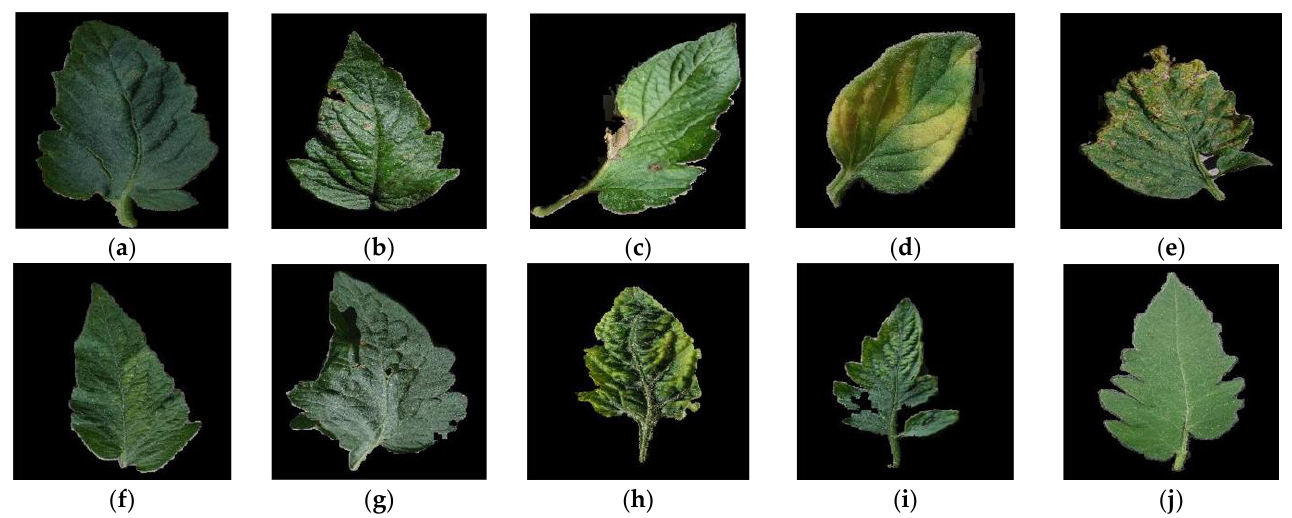
Figure 7. Ten segmented leaf images including nine leaf disease images and one healthy image: ( a ) Bacterial spot disease; ( b ) Early blight disease; ( c ) Late blight disease; ( d ) Leaf mold disease; ( e ) Septoria leaf spot disease; ( f ) Two-spotted spider mites; ( g ) Target spot disease; ( h ) Yellow leaf curl virus dis-ease; ( i ) Mosaic virus disease; ( j ) Healthy leaf.